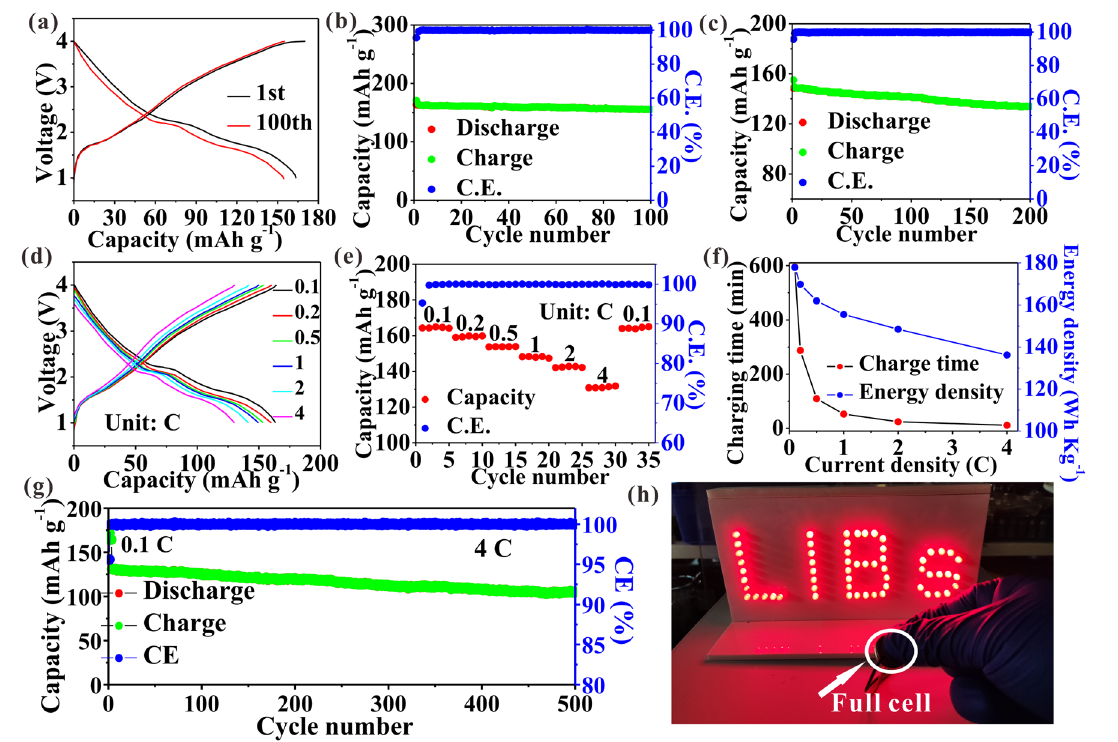
Fig. 6 Full cells testing. a Voltage profiles at 0.1 C. b Cycling curves at 0.1 C. c Cycling curves at 1 C. d , e Rate curves. f Charging time and corresponding E G . g Cycling curves at 4 C. h Lighting